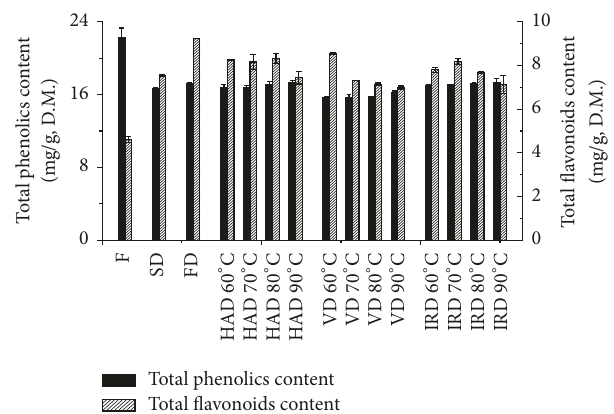
Figure 3: The content variation of total flavonoids content and total phenolics content in tangerine peels dried by different drying